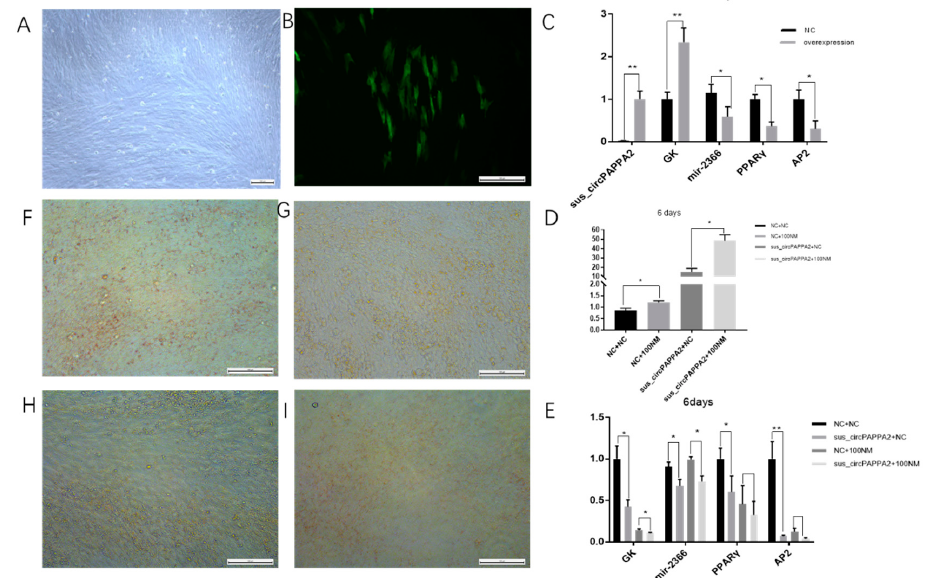
Figure 7. Preadipocyte differentiation experiment in the sus_circPAPPA2-overexpressing group. ( A ) Bright field image of preadipocytes overexpressing sus_circPAPPA2. ( B ) Fluorescence image of anterior adipocytes after the overexpression of sus_circPAPPA2. ( C – E ) qPCR quantification of related genes. ( F ) Oil red O staining was performed 6 days after differentiation in the NC group without testosterone addition. ( G ) Oil red O staining was performed 6 days after differentiation in the sus_circPAPPA2 overexpression group without testosterone addition ( H ) The NC group was differentiated with 100 nm of testosterone for 6 days after oil red O staining ( I ) The overexpressed sus_circPAPPA2 group was differentiated with 100 nm of testosterone for 6 days after oil red O staining. NC indicates the control group, sus_circPAPPA2 indicates the circRNA overexpression group, Nc + 100 nM indicates the NC group treated with 100 nm of testosterone and sus_circPAPPA2 + NC indicates the circRNA overexpression group treated with 100 nm of testosterone. * indicates p < 0.05, ** indicates p < 0.01. All pictures are magnified 100 times, n = 3.